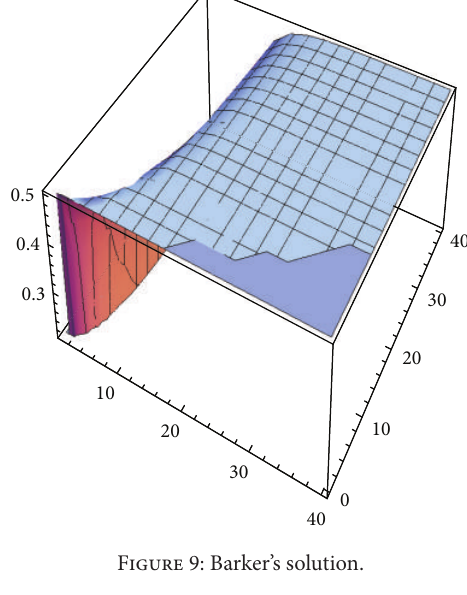
Figure 7: Solution of (41) (drawdown).